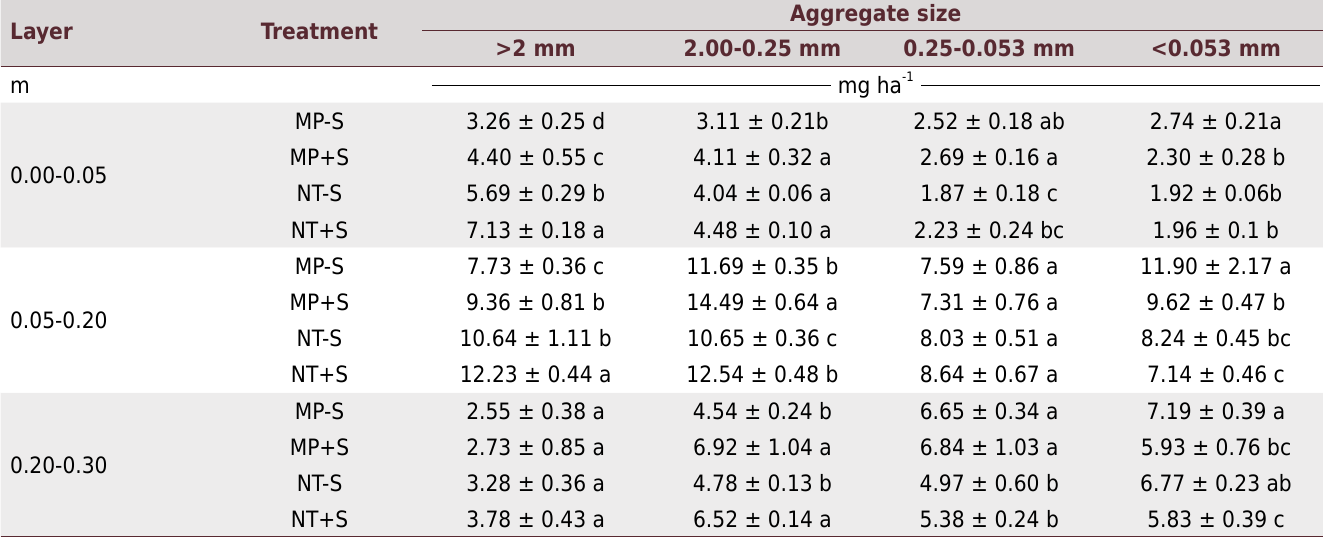
Table 3. Soil organic carbon (SOC) storage (± standard deviation, n = 3) in varied aggregate size fractions in different soil layers as influenced by